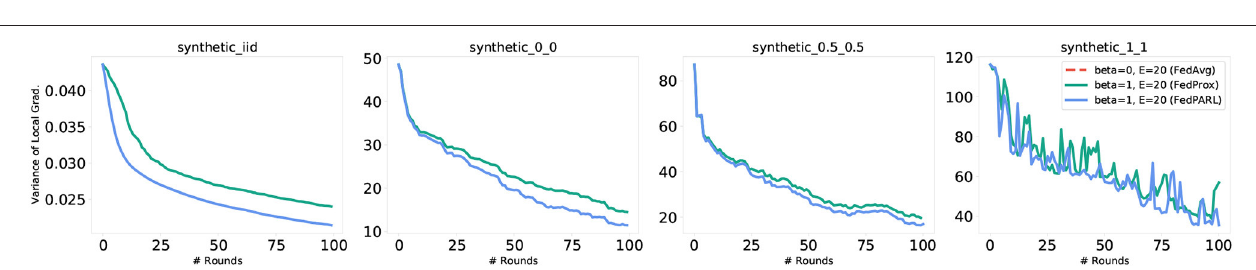
FIGURE 16 | Simulation of data heterogeneity effects on variance of local gradients by considering four synthetic datasets. From left to right, the statistical heterogeneity